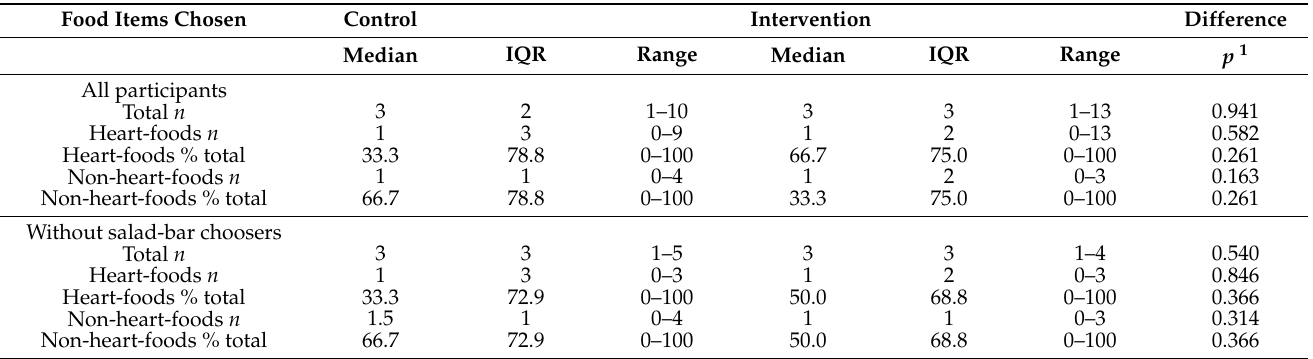
Table 4. The food items chosen at serving line stretch #2. All participants: control n = 22, intervention n = 19. Without salad-bar choosers: control n = 20, intervention n =